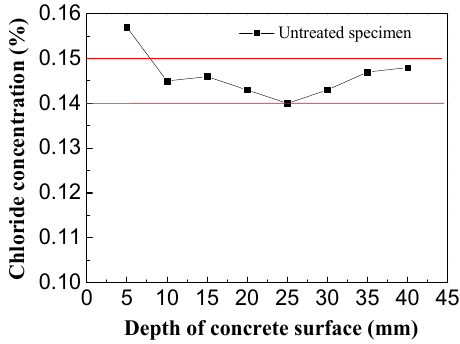
Figure 11. Initial chloride concentration in concrete.